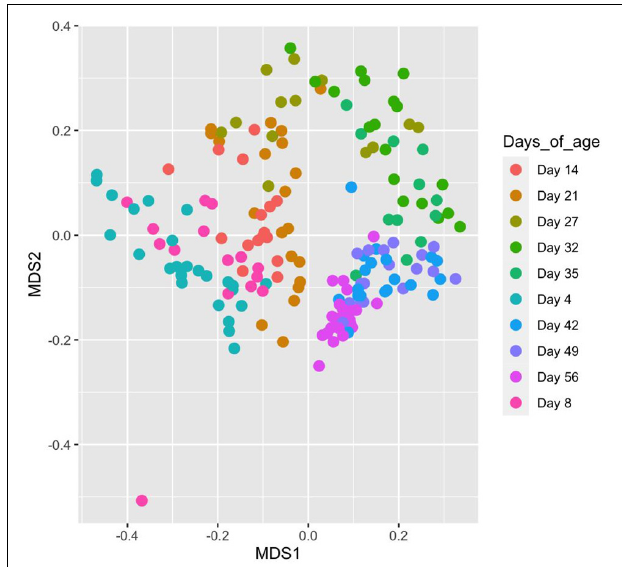
FIGURE 5 | MDS plot showing changes in, and the relatedness of, faecal microbiota community composition with sample age calculated using Bray–Curtis distances. Points on the plot represent individual piglet samples which are positioned on the plot based on their similarity to other communities in two-dimensional space. Points more closely clustered represent microbiota communities more closely related to one another based on taxa composition and